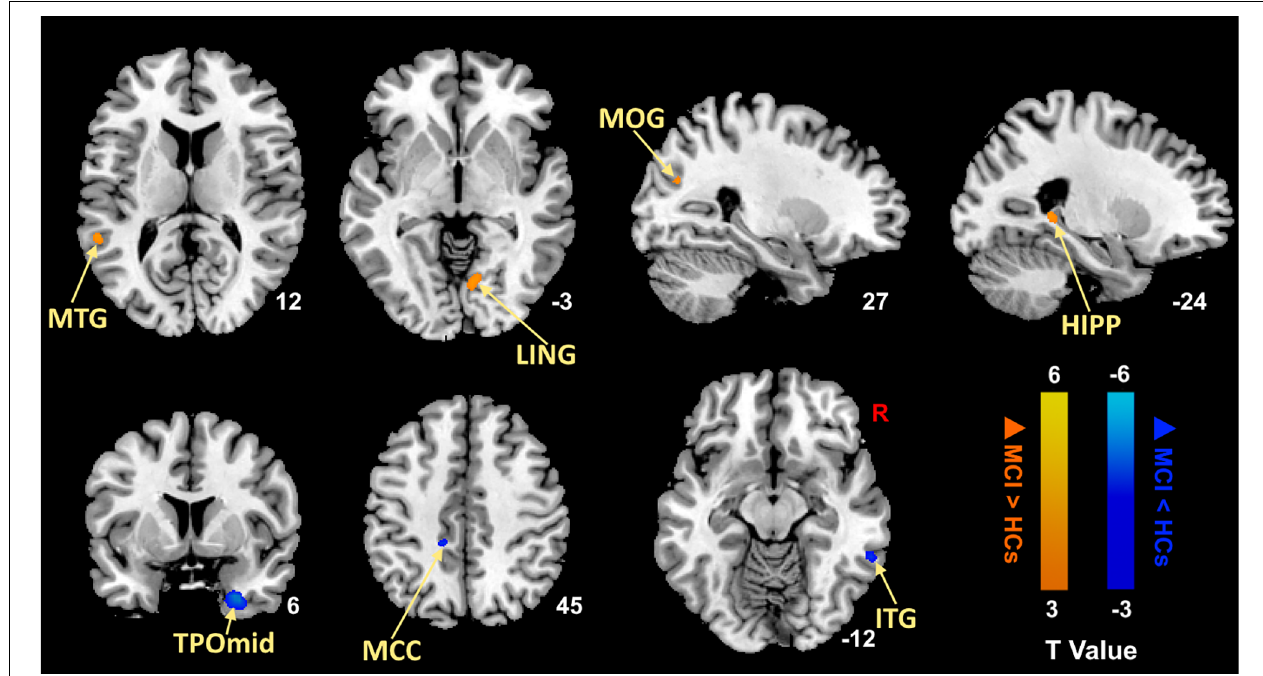
FIGURE 1 | Brain regions with significantly different ALFF values of MCI patients compared with HCs ( p < 0.05, FDR correction). Warm color represents an increase and cool color represents a decrease respectively. ALFF, amplitude of low-frequency fluctuation; FDR, false discovery rate; MTG, middle temporal gyrus;